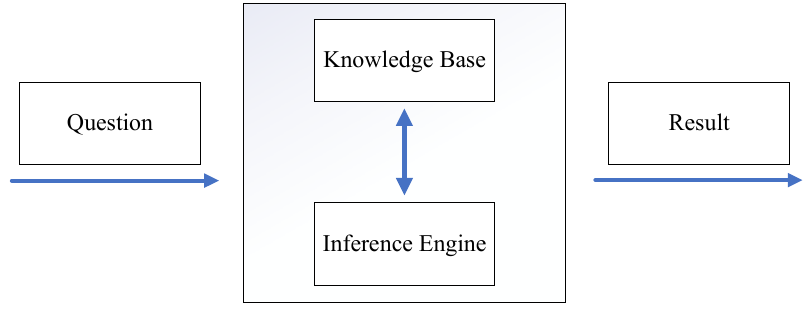
Figure 4. Expert systems.